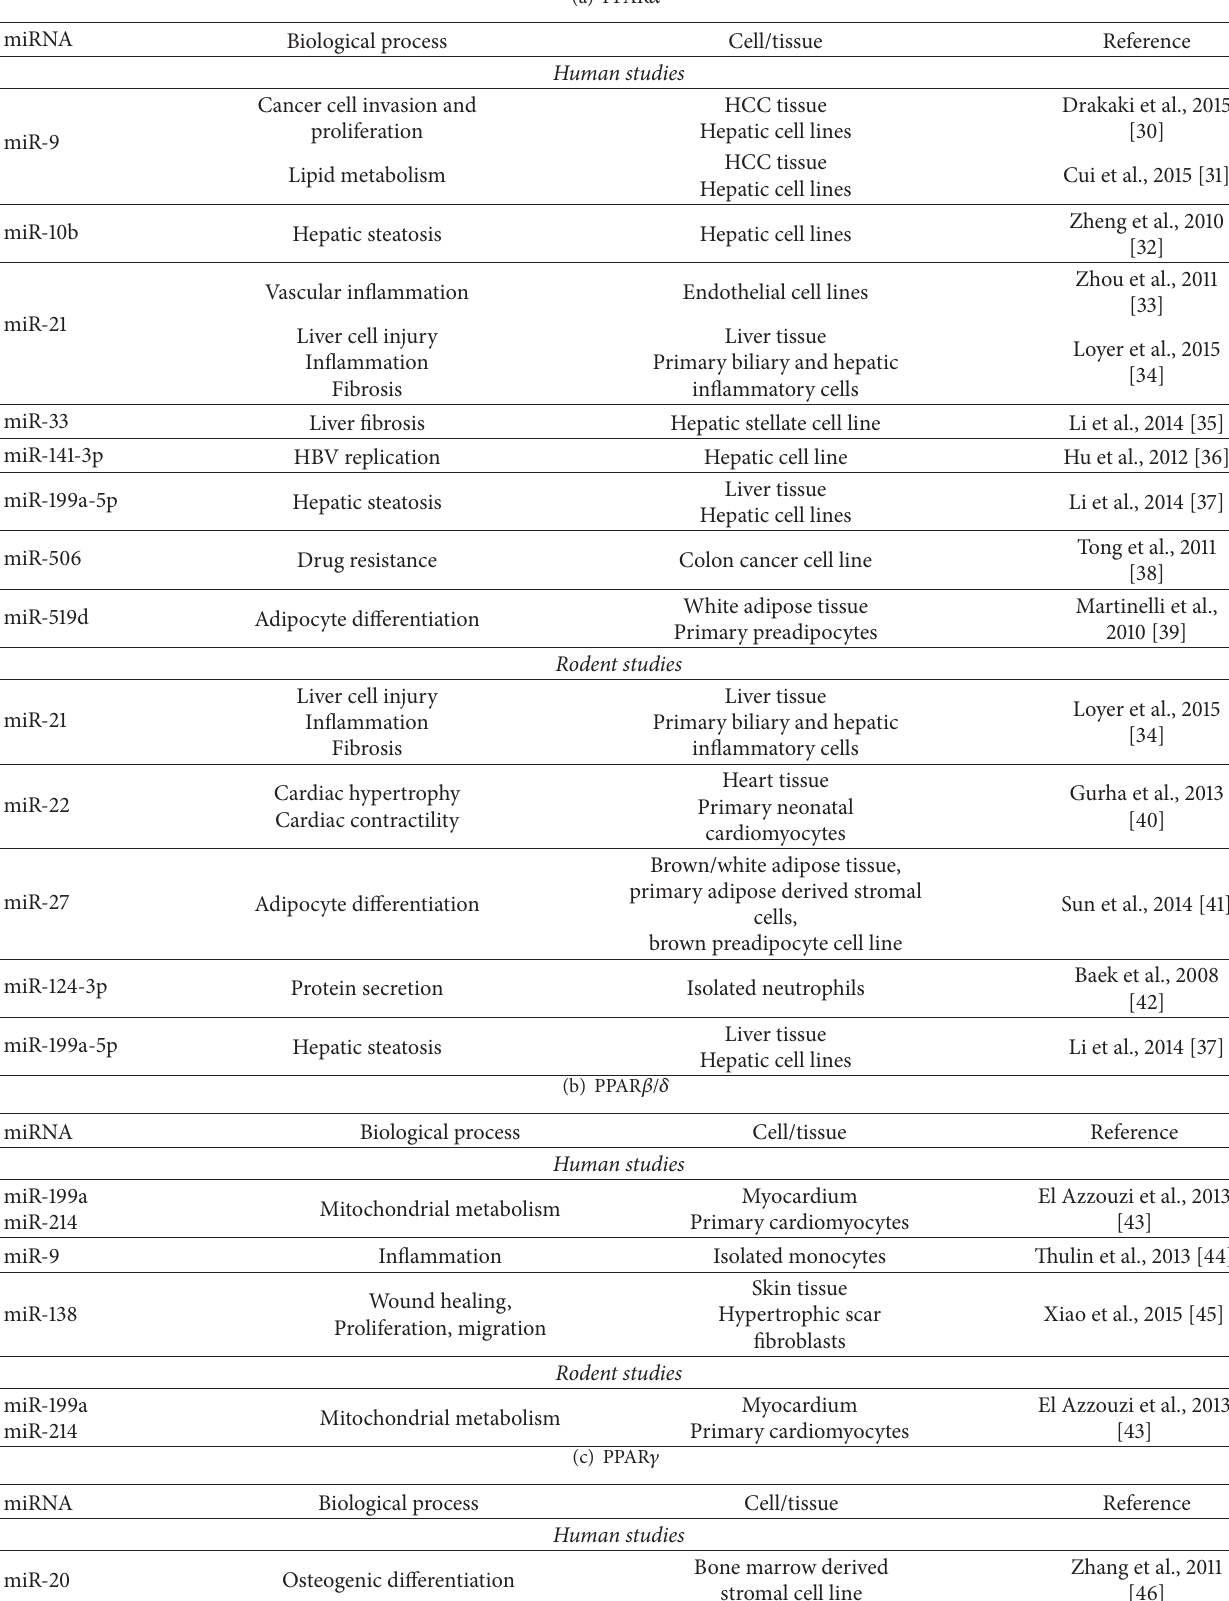
Table 1: Experimentally validated miRNAs targeting PPAR isoforms in specific tissues and pathophysiological